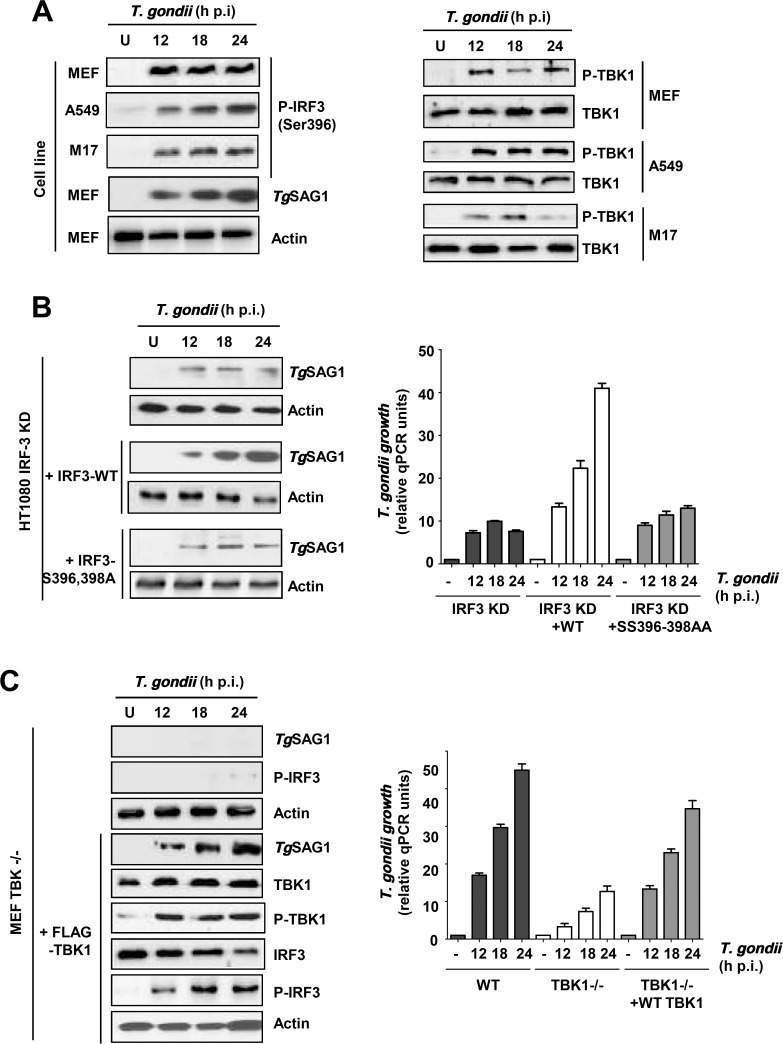
IRF3 phosphorylation is essential for PISA and T. gondii replication.Parasite infection and growth analyses were performed as described in Fig. 1A. Immunoblotting detected the indicated proteins, including phospho-IRF3 (P-IRF3), using a phospho-Ser396-specific antibody. A, The cell lines used are indicated. B, IRF3 KD (knocked-down) HT1080 cell line or these cells, reconstituted with WT or 396/98AA mutant of IRF3, were used for T. gondii infection. C, The indicated TBK1 KO and FLAG-TBK1-restored MEFs were used for T. gondii infection. Where shown, parasite growth was quantified by qPCR of genomic DNA.